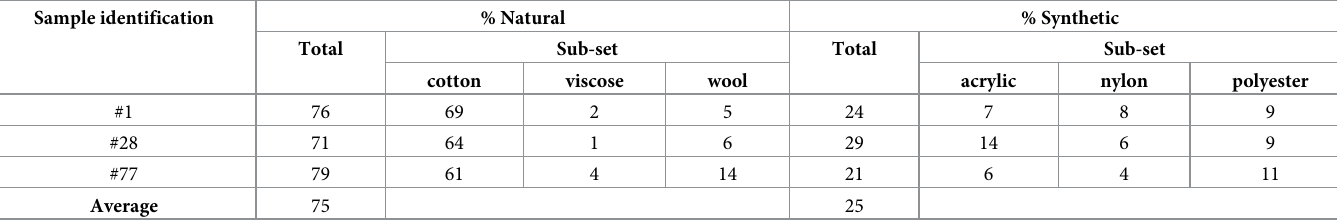
Table 1. Summary of colored fiber identification using optical and FT-IR microscopy. Sample